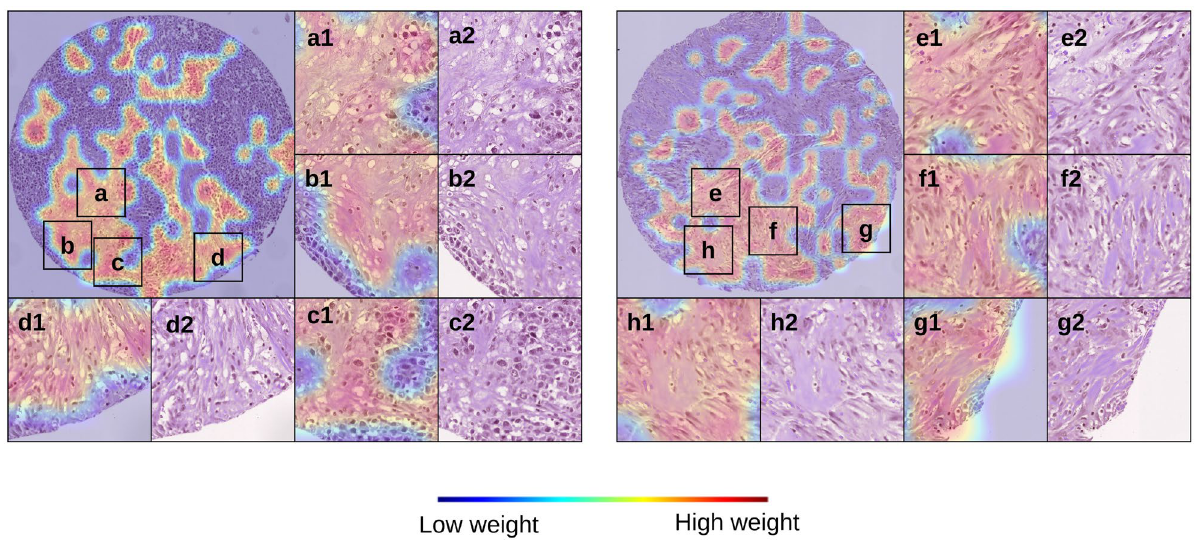
Figure 6. Heatmaps (a1–h1) and corresponding H&Es (a2–h2) from a representative case categorised as high-risk by the MIL classifier. The features present are those of a stroma-rich, low-TILs tumour and low-TILs